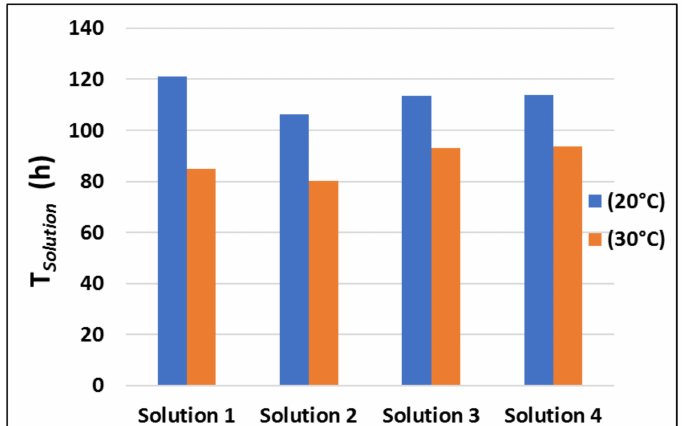
Figure 12. Time required for painting the whole monopile with the different solutions calculated at two different temperatures of 20 and 30 ◦